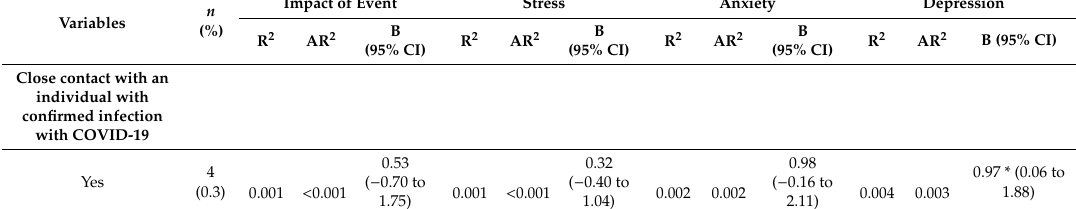
Table 3. Association between contact history in the past 14 days and the psychological impact of the 2019 coronavirus disease (COVID-19) outbreak as well as adverse mental health status during the epidemic ( n = 1210). Impact of Event Stress Anxiety n Variables (%)